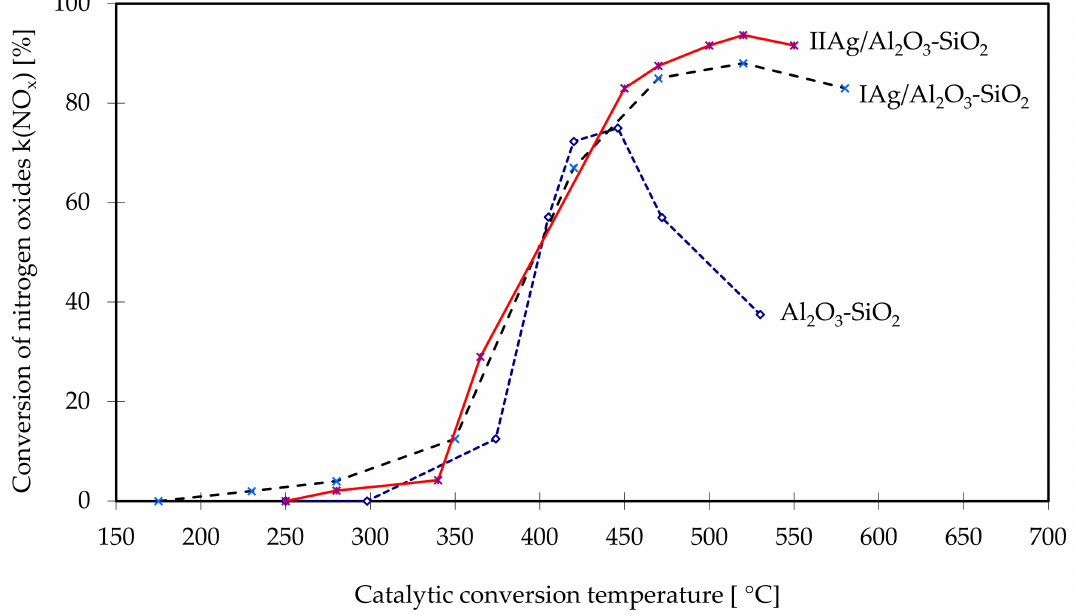
Figure 2. Conversion of nitrogen oxides in the tested converters as a function of the temperature of the catalytic